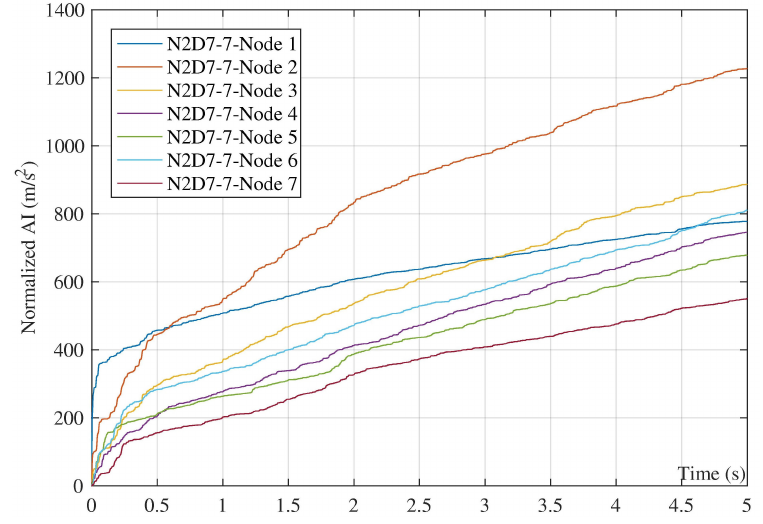
Figure 15. Normalized AI for 100% damage in cable 2 under moving load.